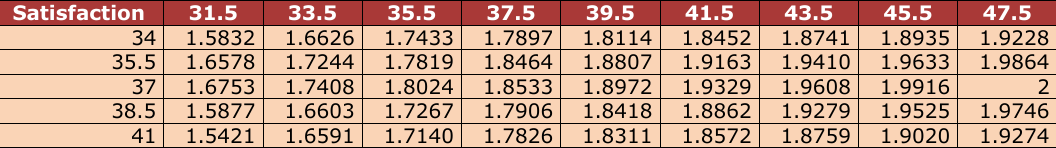
Table 9. Overall satisfaction of Nanchang-Jiujiang Inter-city High-speed Railway and Nanchang-Jiujiang